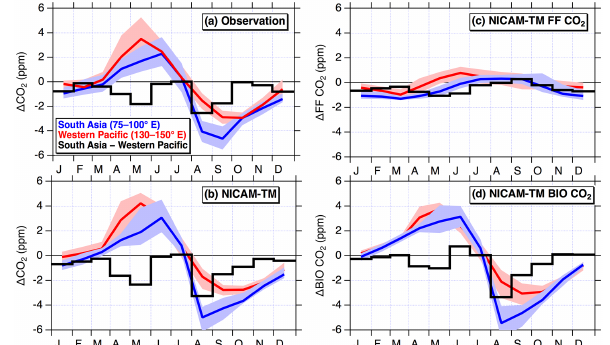
Figure 7. (a) Seasonal variations in (cid:49) CO 2 in the UT over South Asia (blue; 20–30 ◦ N, 75–100 ◦ E) and western Pacific (red; 20– 30 ◦ N, 130–150 ◦ E). Lines and shades are monthly medians, and 25th and 75th percentiles, respectively. Black solid line shows monthly difference of (cid:49) CO 2 between the two areas (South Asia – western Pacific, i.e., longitudinal gradient). (b) Same as in (a) , but for the NICAM-TM simulated data. (c) Same as in (b) , but for FF CO 2 in the model. (d) Same as in (b) , but for BIO CO 2 in the